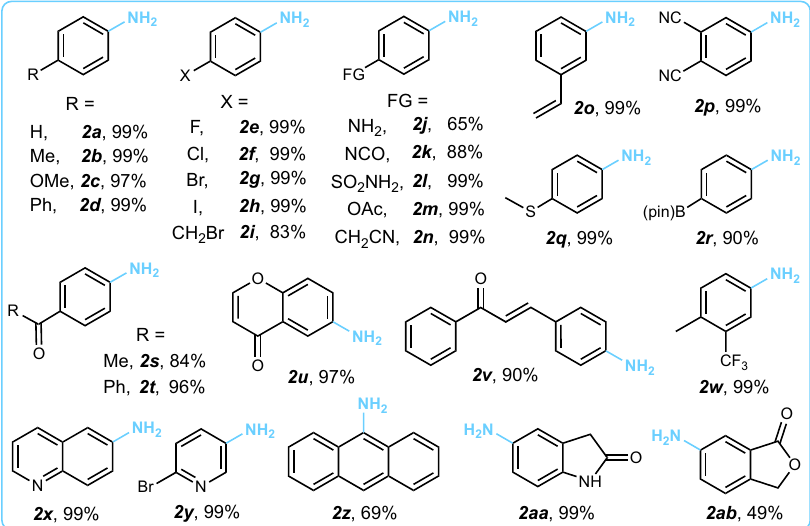
Fig. 5 Reaction scope. Substrate scope of the Pt 1 -MoS 2 -GF catalysed nitroarene reduction in the quantitative conversion regime. The yields obtained through gas chromatography-mass spectrometry at the optimal conditions are shown here. Further details are provided in Supplementary Fig. assigned to the nitro group adsorbed via the “ end-on ” con fi g- N 2 at 70 °C on Pt 1 -MoS 2 and a control sample of Pt nanoparticles uration and its reduced intermediates (phenylhydroxylamine & on MoS 2 38,40 . The adsorption mode of alkene depends on the substrate, it shows a weak adsorption via π -bonded mode on nitrosobenzene) 41 . This suggests that the reaction proceeds through a direct hydrogenation route to form aniline, rather than isolated single atoms in comparison to strong ethylidyne (tri- the condensation route to form azobenzene 42 . For the control dentate) or di- σ (bidentate) con fi guration on nanoparticles. By sample, we observed two additional bands at 1116 and 1214 cm − 1 , contrast, the adsorption of nitro functionality prefers a mono- which are probably related to the planar binding con fi guration of dentate “ end-on ” con fi guration 41 . Three absorption bands were the alkene groups. We have also conducted the CO-DRIFT and CO observed at 1000, 1310, and 1402 cm − 1 in the Pt 1 -MoS 2 spectra stripping experiments in Supplementary Fig. 32, where CO (Fig. 4d, Supplementary Fig. 30 and 31). These bands were